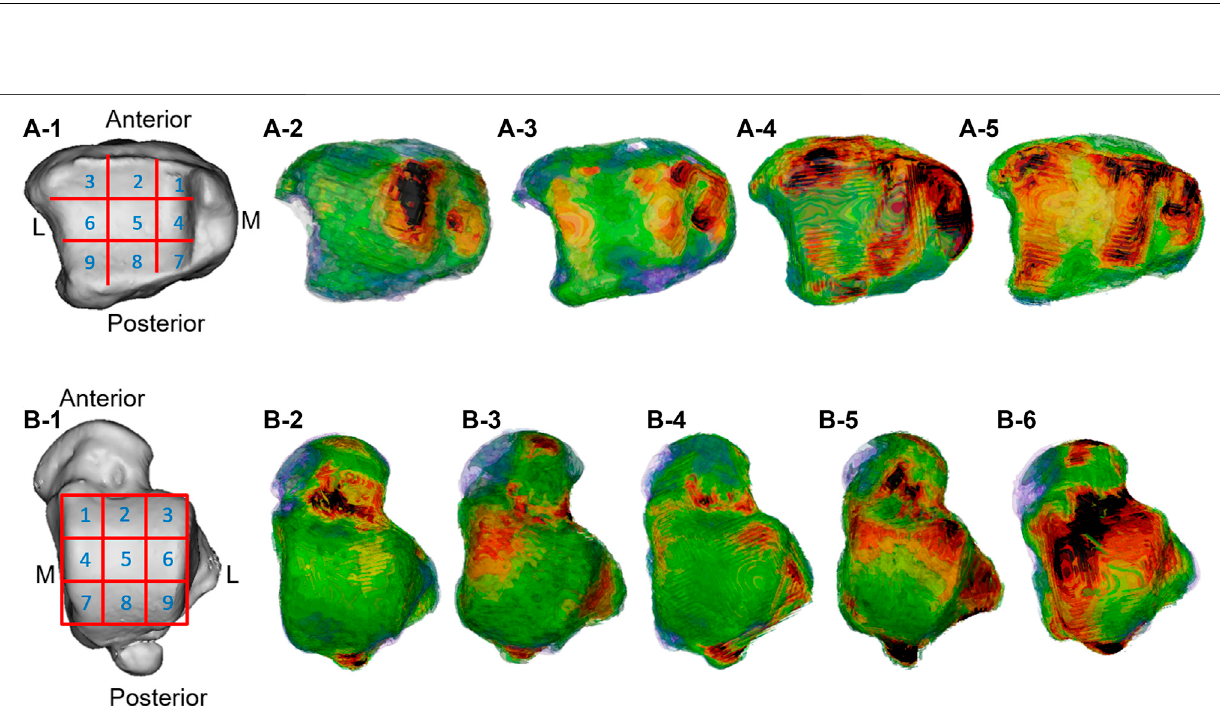
Frontiers in Bioengineering and Biotechnology |